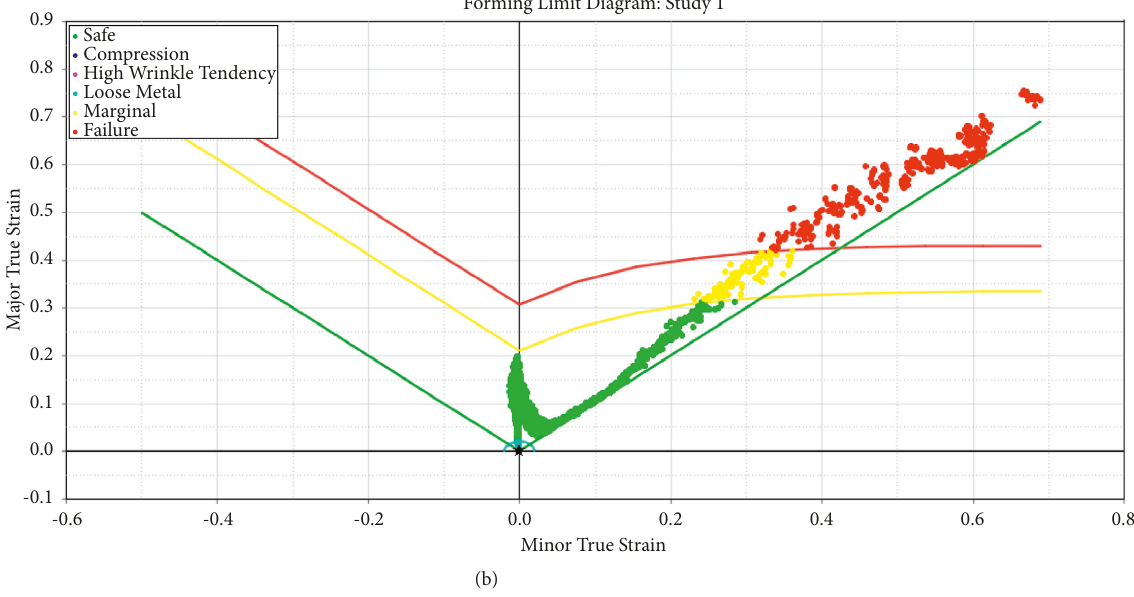
Figure 9: FLD of APA blank #1 with a zero friction coefficient between the punch and blank.